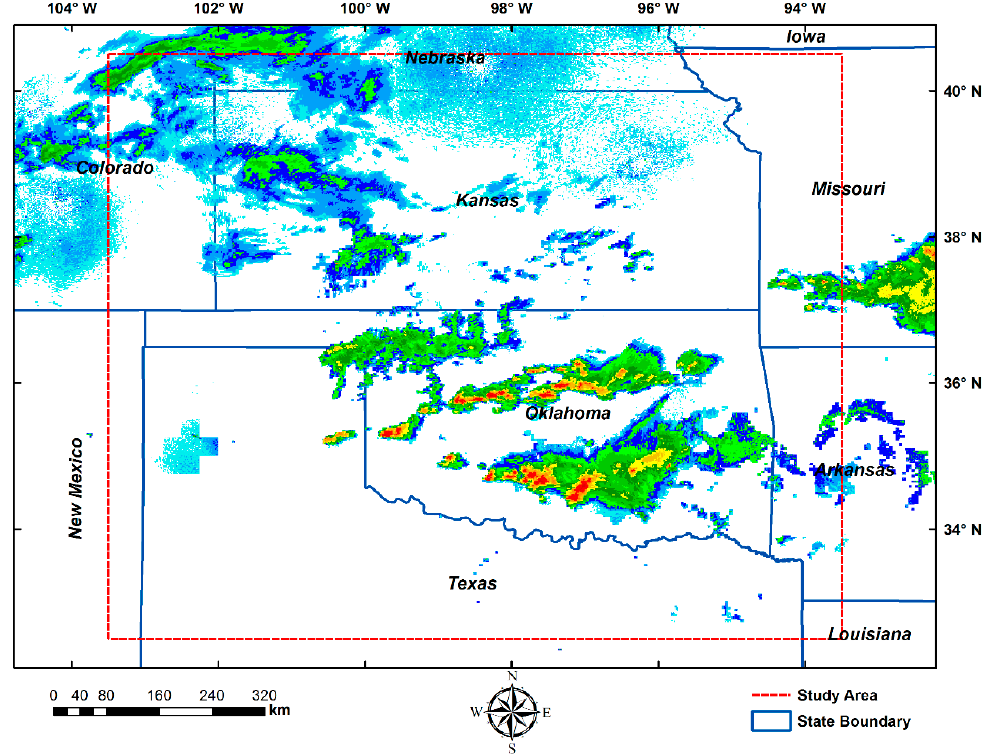
Figure 1. The study area (highlighted in red dashed rectangle) mainly covers the states of Kansas, Oklahoma, and northern Texas. A radar reflectivity image at 8:00, 24 April 2011 UTC is shown as an example.